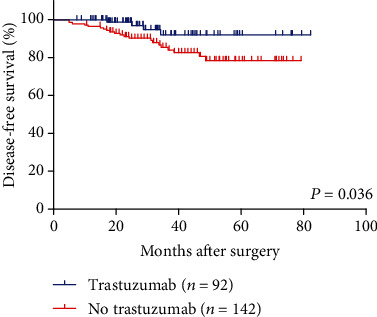
Association of trastuzumab use with DFS.